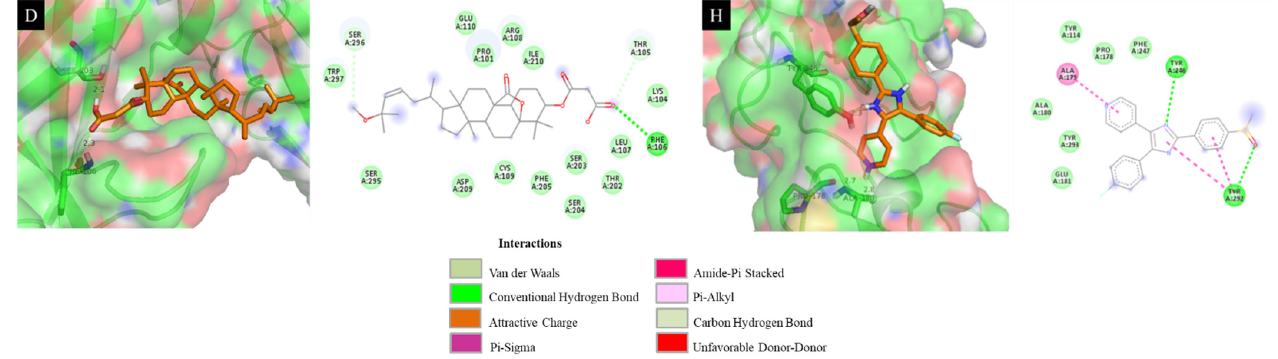
Figure 4. Docking simulation of the interactions between compounds 4 – 6 ( A – C ), 8 ( D ), 9 ( E ), 11 ( F ), 12 ( G ), and SB203580 ( H ), respectively, and the 1F42 protein of IL-12 p40 expression.